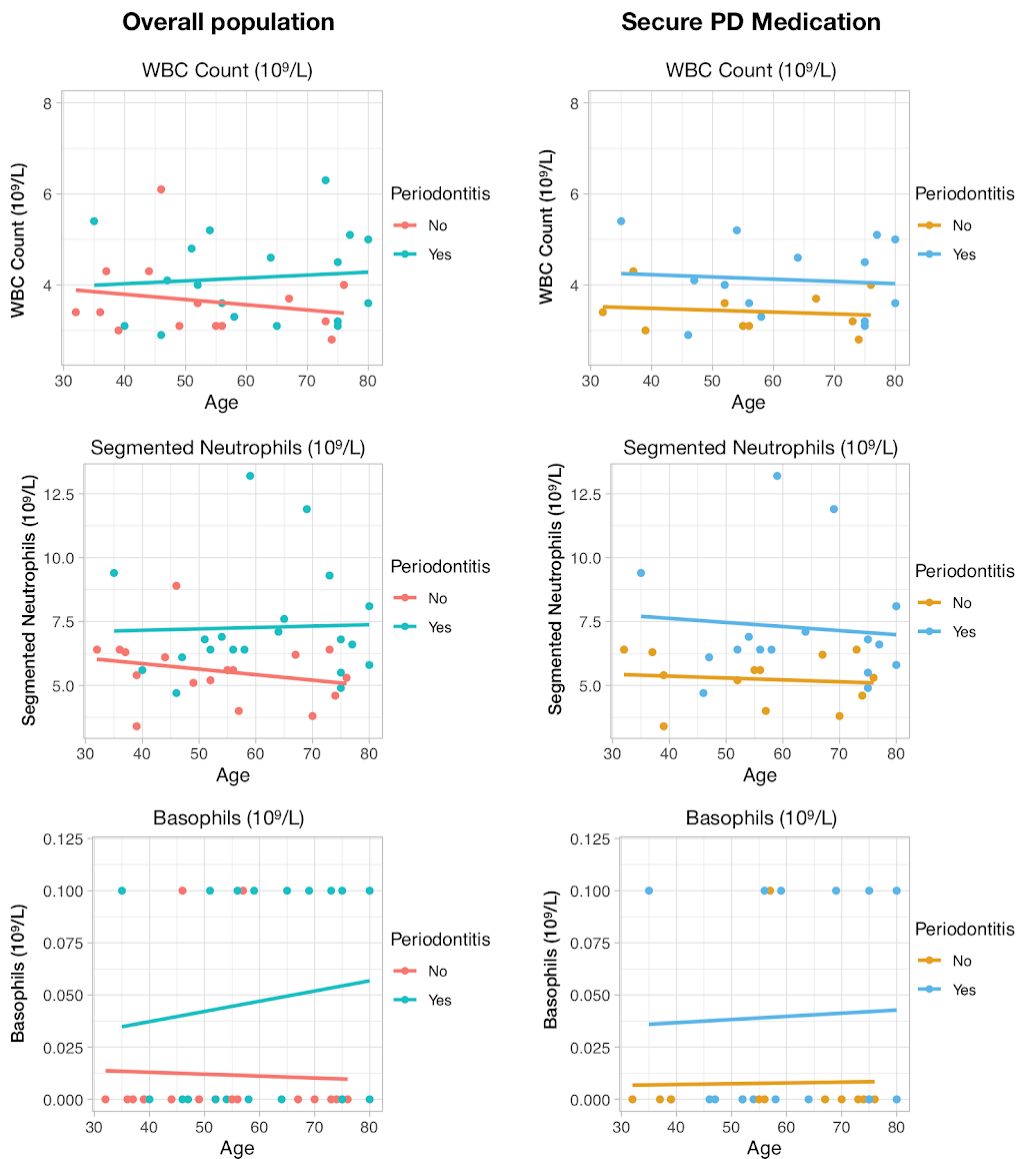
Figure 1. Comparison of WBC Count, Segmented neutrophils and Basophils serum levels between Periodontitis and no Periodontitis PD participants both in the overall sample and Secure PD medications. Lines represent graphically the tendency.